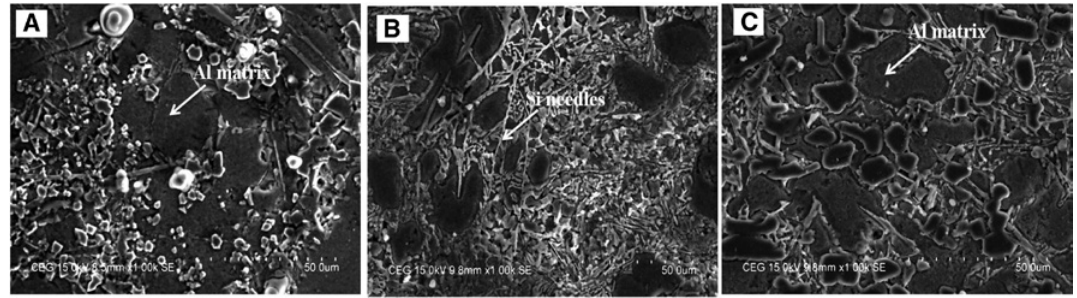
composites fabricated at 10 min AT and HTs of (A) 20 min (B) 30 min, and (C) 40 min. Figure 2: Microstructures of the Al/TiB 2